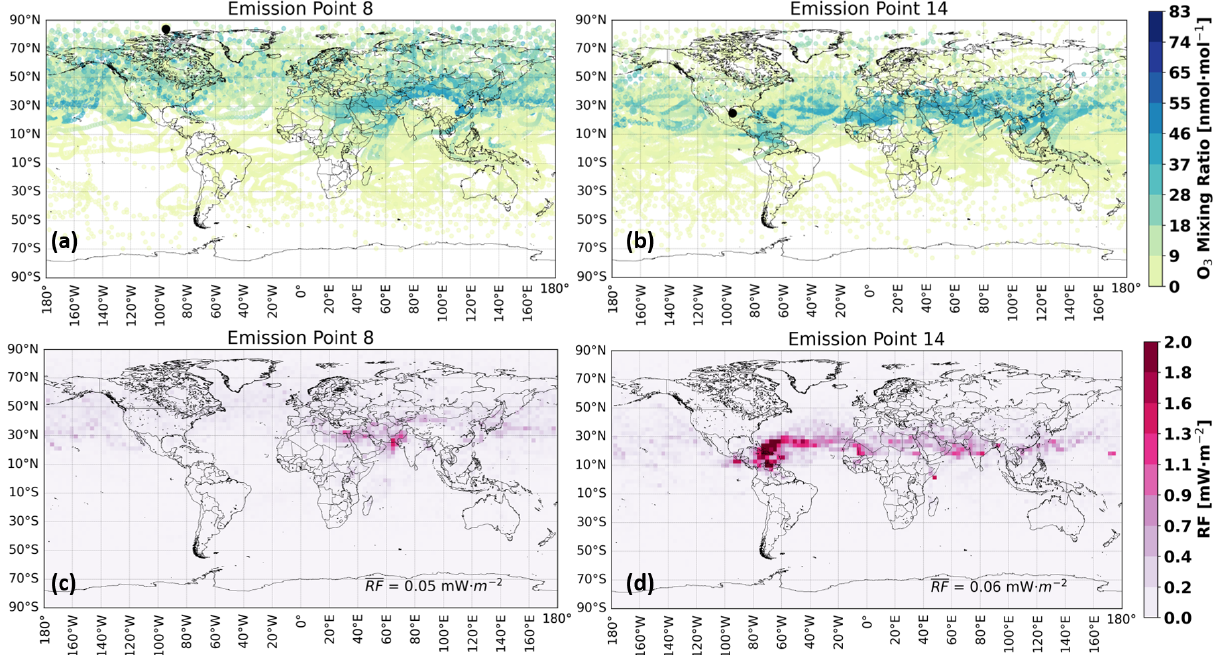
Figure 10. Horizontal profiles of mean O 3 disturbances in N. America in nanomoles per mole (nmolmol − 1 ) during January 2014 for (a) emission point 8 and (b) emission point 14. The mean radiative forcing RF in milliwatts per square meter (mWm − 2 ) for (c) emission point 8 and (d) emission point 14. The black dots in (a) and (b) represent the emission starting points.